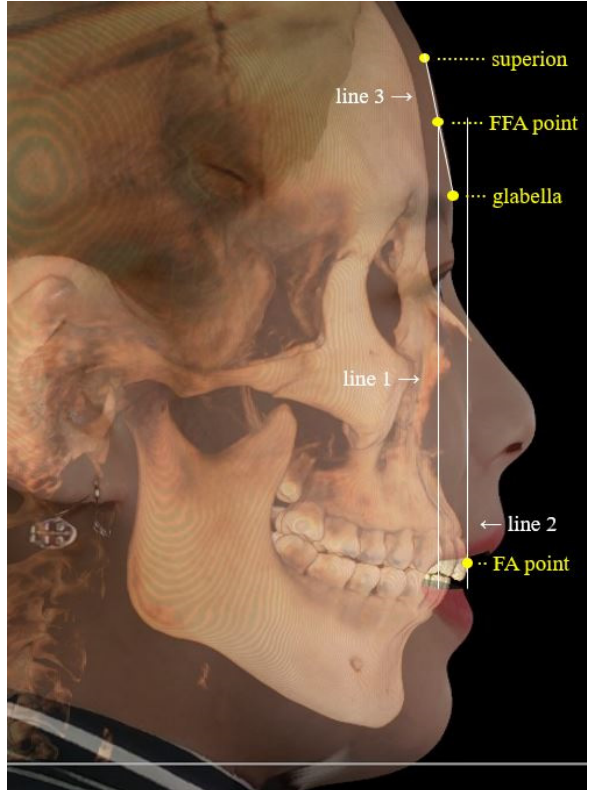
Figure 3. Profile analysis on the program. Each reference point is identified in yellow. Line 1 is the vertical line constructed from the FFA point. Line 2 is the vertical line constructed from the FA point. Line 3 is formed by connecting the superion and the glabella. FA: facial axis; FFA: forehead facial axis.